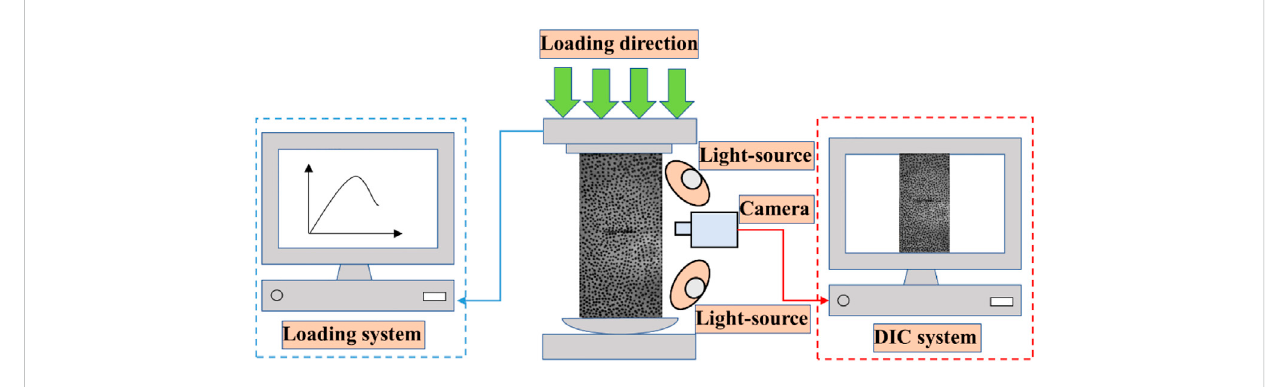
FIGURE 1 Schematic diagram of the test system.